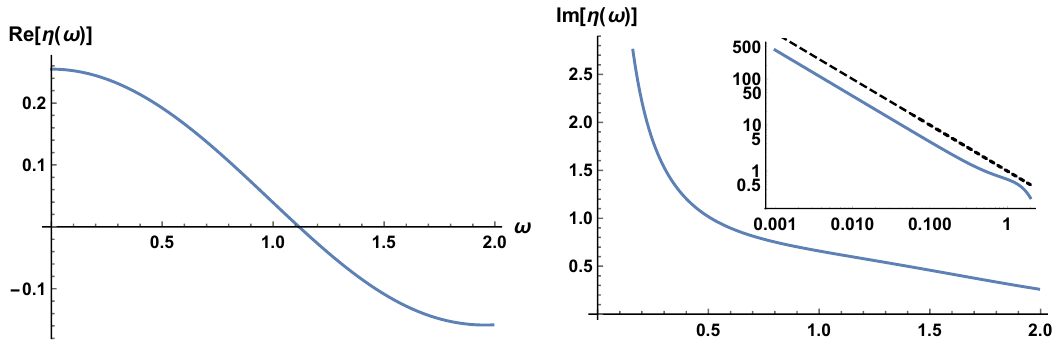
Figure 5 . The frequency dependent viscosity (4.1) for the potential V ( X ) = X 3 at m=T (cid:25) 3 : 5. Left: the real part showing the zero frequency value (cid:17) . Right: the imaginary part showing the 1 =! pole and the absence of (cid:10). The inset is a log-log plot to show more clearly the low frequency behaviour.